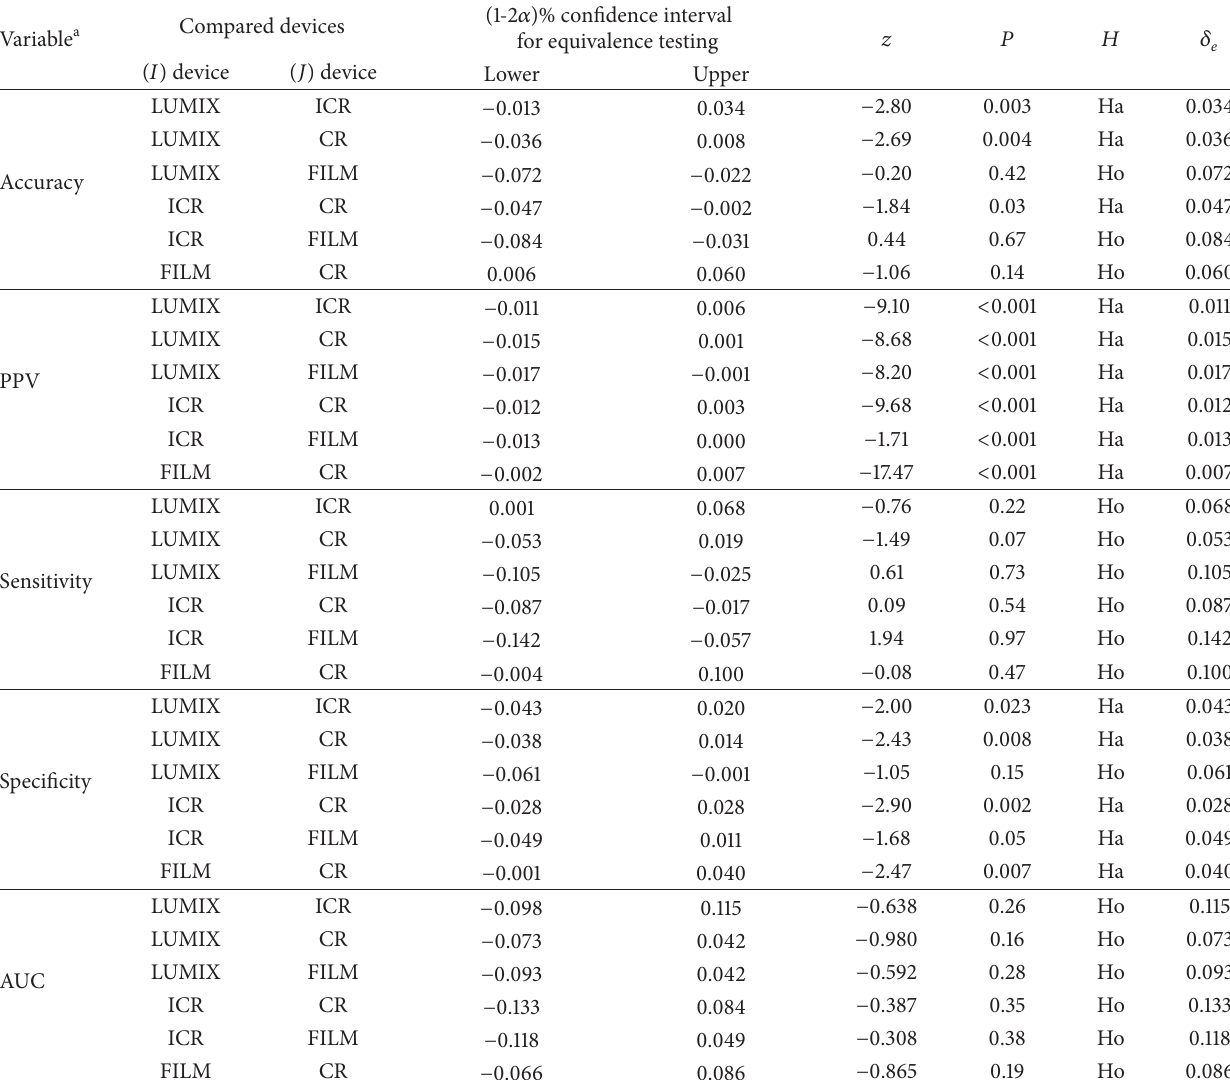
Table 7: Equivalence tests for accuracy, PPV, sensitivity, specificity, and AUC by paired devices ( 𝛿 = 0.05). Variable a